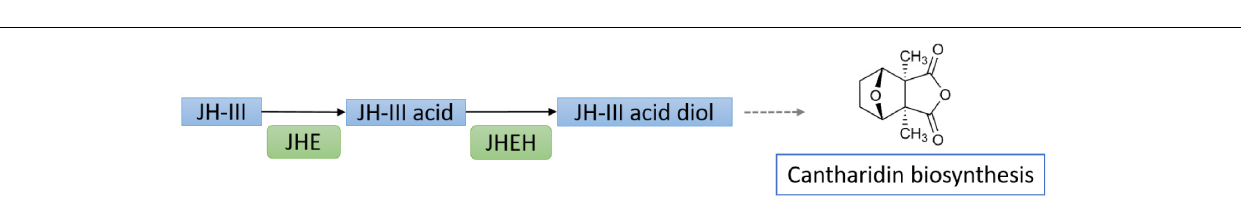
FIGURE 7 | Schematic diagram showing the potential involvement of juvenile hormone in regulation of insect defensive toxin production. The metabolism of JH-III through its degradation pathway by JHE and JHEH is essential for the biosynthesis of the defensive toxin cantharidin in blister